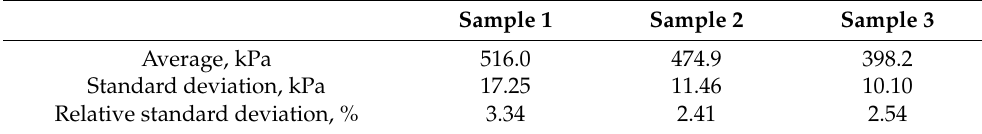
Table 2. Stiffness of the N-BCNT/PU-silicone rubber flexible piezoresistive